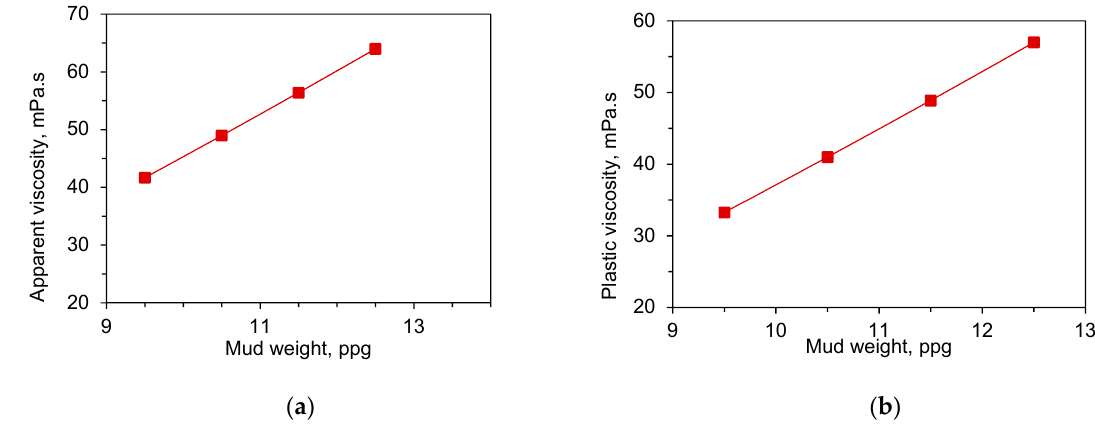
Figure 6. Impact of mud weight on ( a ) AV and ( b ) PV of the 7.5 wt.% PAM/PEI-based drilling fluid at 200 °F.